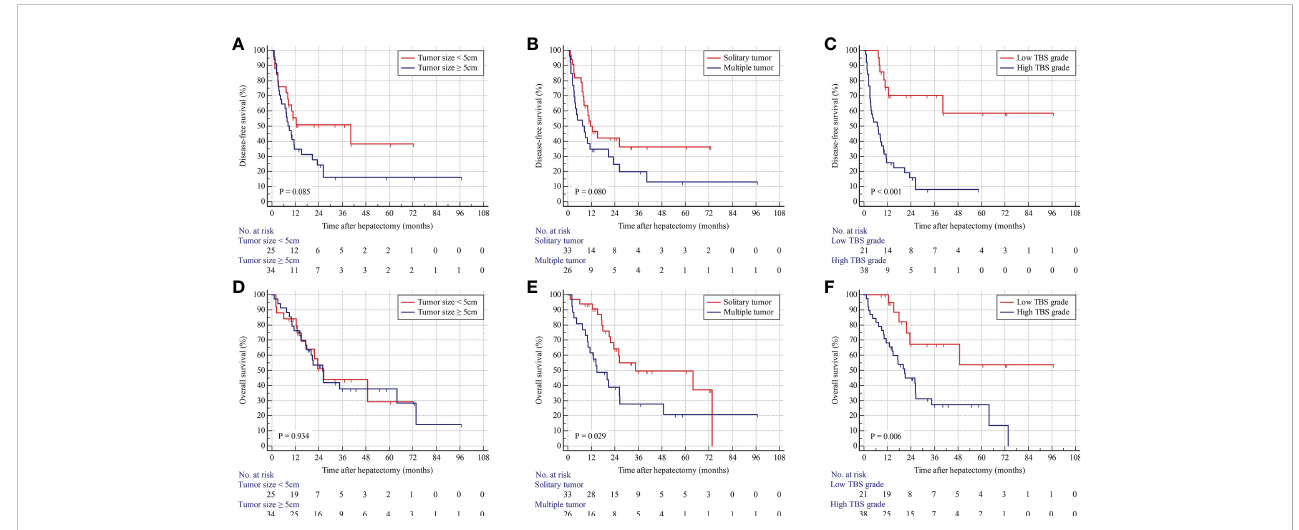
FIGURE 3 Kaplan – Meier curves for DFS and OS strati fi ed by tumor size (A, D) , tumor number (B, E) , and TBS grade (C, F) in the validation